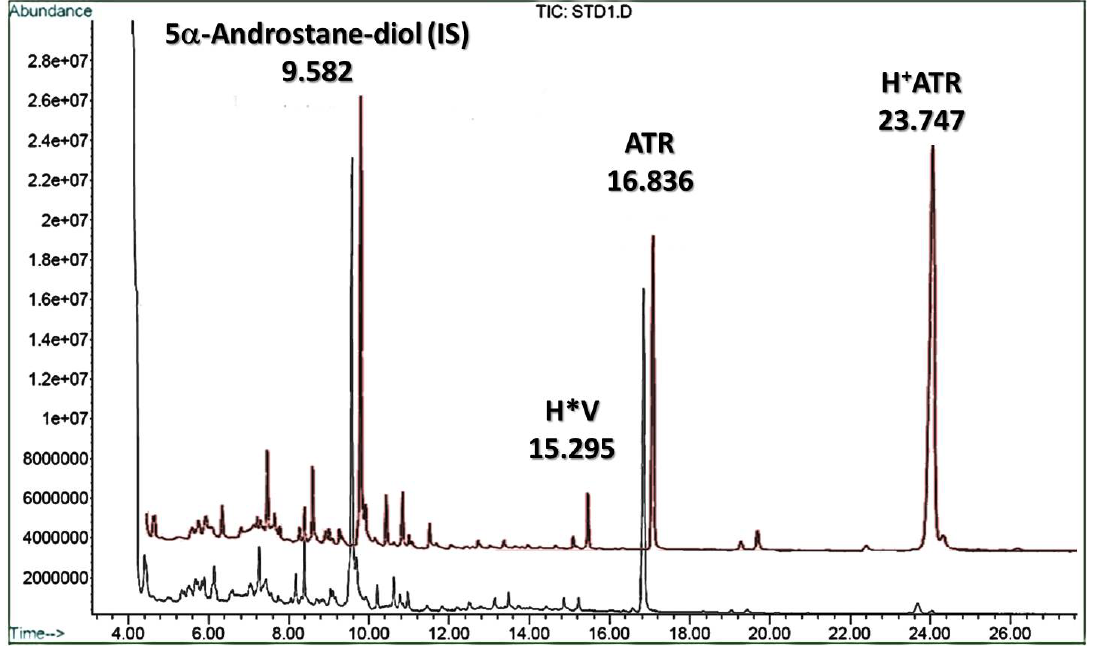
Figure 3. Chromatograms obtained from the TMS derivatives of the hydrolyzed ATR (in red) with the spiked ATR of 100 μ g/mL and the internal standard (IS) for comparison.